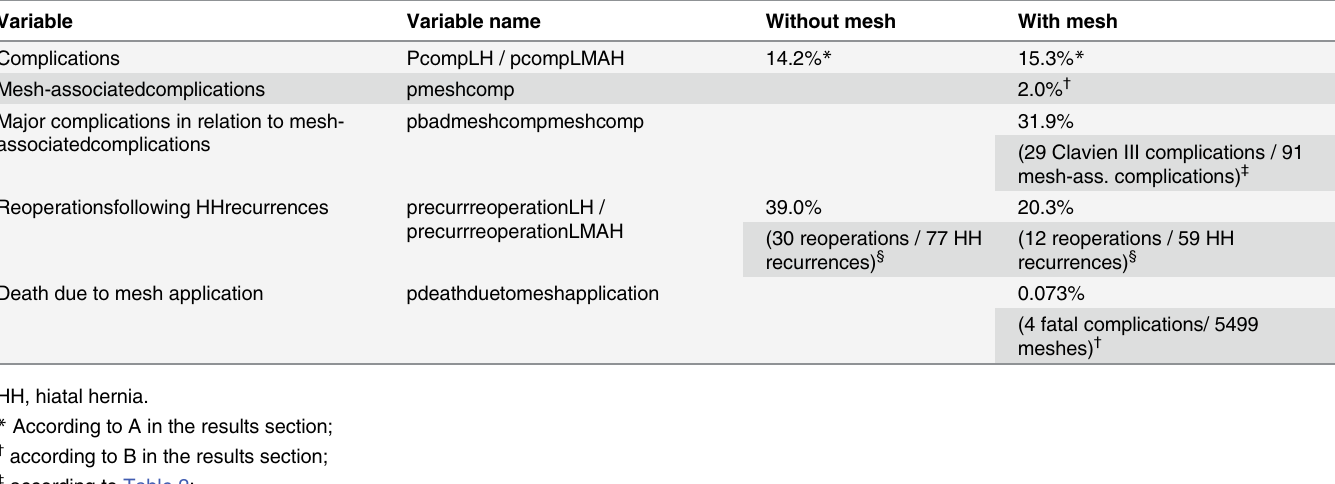
Table 1. Input variables for probabilities (p) in the Markov Monte Carlo decision-analytic